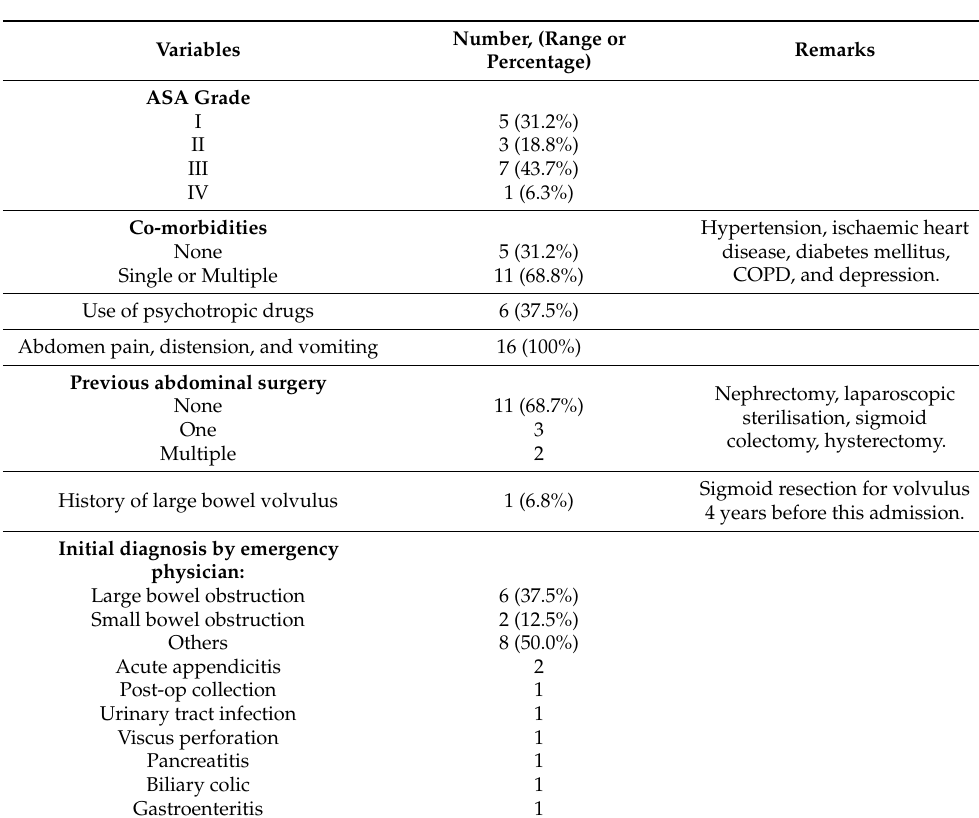
Table 2. Clinical